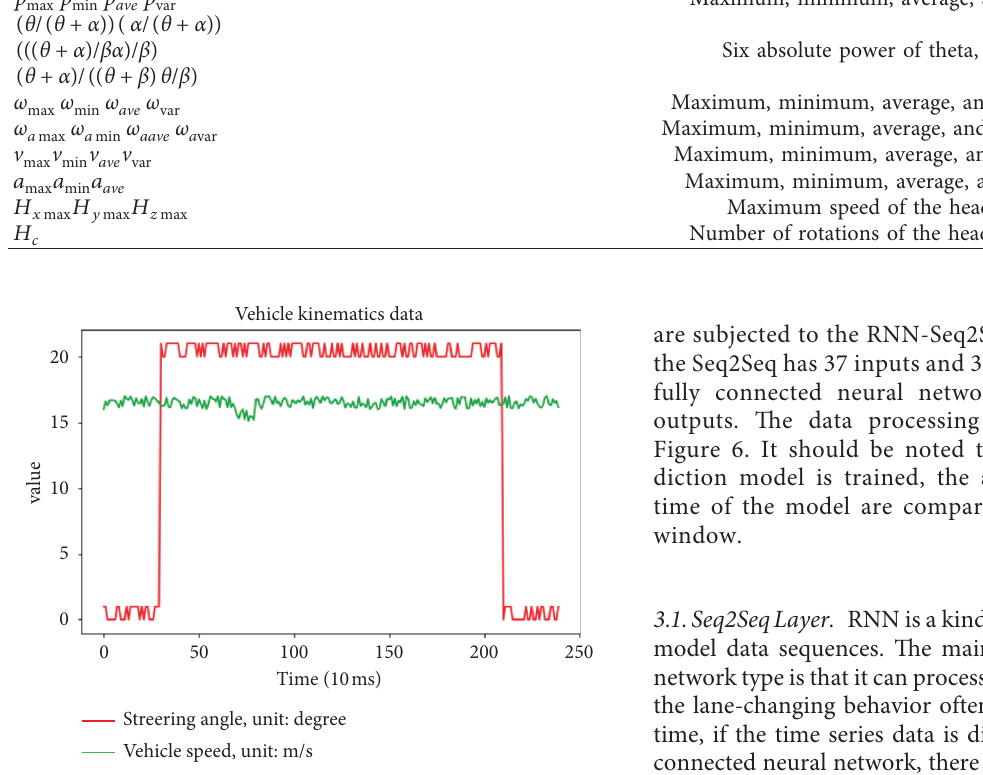
Figure 4: Vehicle kinematics data during the lane-changing process.